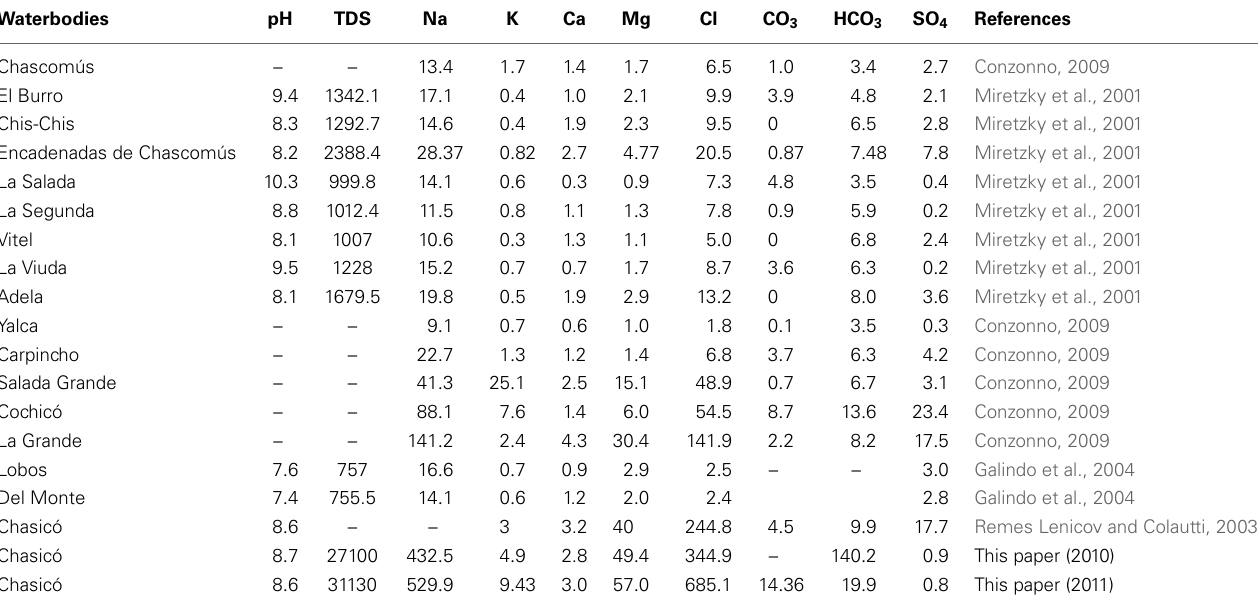
Table 1 | pH, Total dissolved Solids (TDS, mg/L) and major ionic concentrations (meq/ L) of some Pampean water bodies.